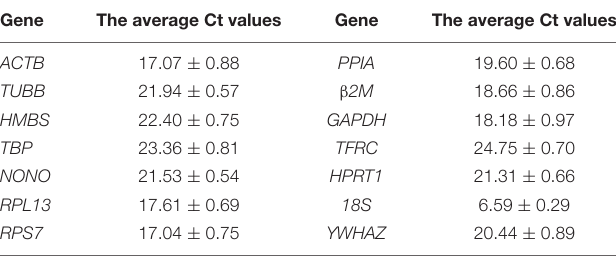
TABLE 3 | The average Ct values of the 14 reference genes in the adipose tissue of